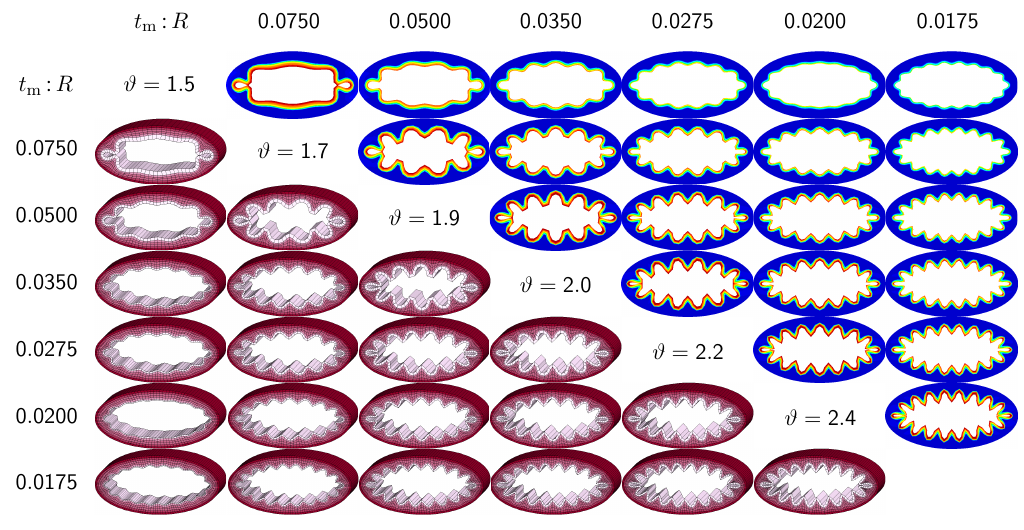
in severely elliptical cross-sections than in circular and moderately elliptical